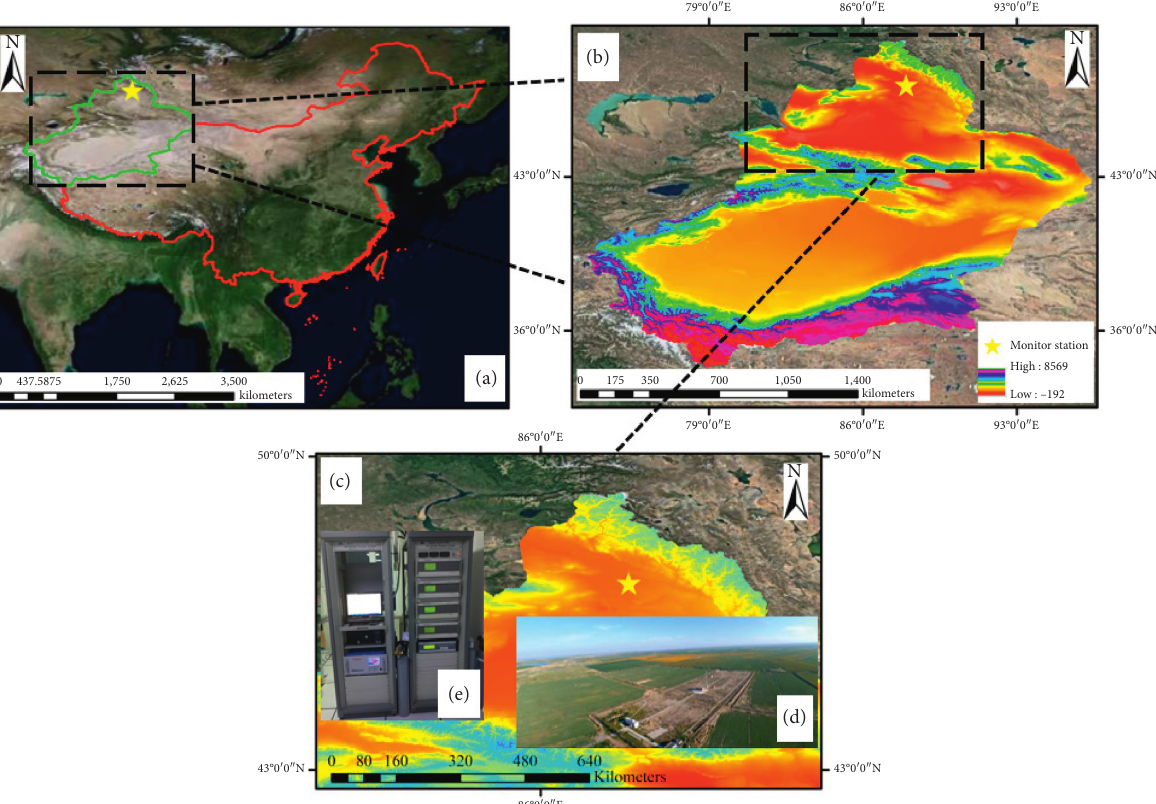
Figure 1: Location of the Akedala regional atmosphere background station, with the yellow star representing the location of Akedala: (a) geographical location of Xinjiang, China; (b) elevation map of Xinjiang; (c) broadened version of the study area; (d) picture of a UAV flying over Akedala; (e) observation equipment at the Akedala